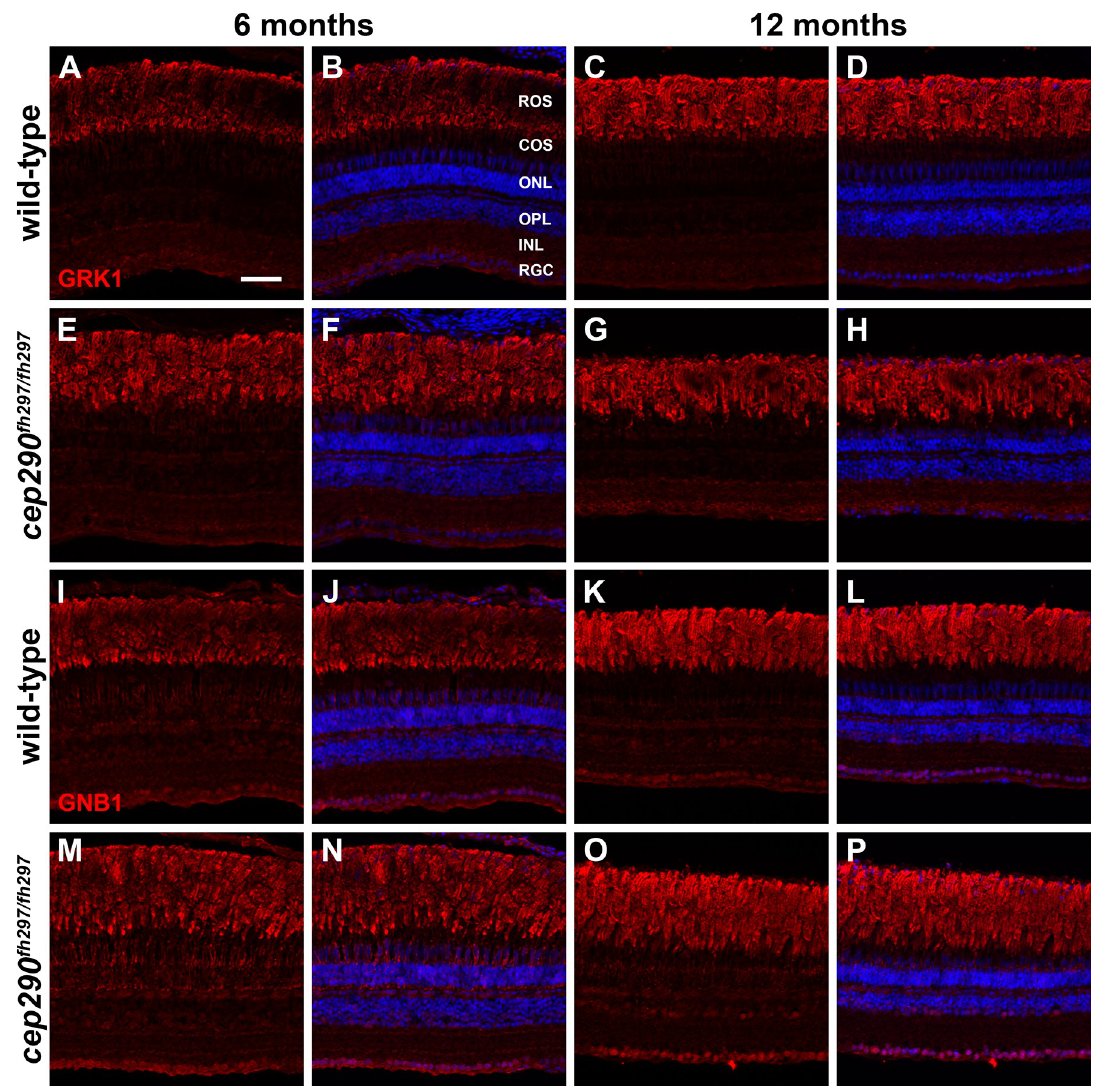
Fig 7. Immunolocalization of GRK1 and GNB1 in cep290 fh297/fh297 mutants at 6 and 12 months of age. Retinal cryosections of cep290 fh297/fh297 mutants and wild-type siblings were stained with polyclonal antibodies against rhodopsin kinase (A-H; GRK1) or with GNB1 polyclonal antibodies against the β subunit of rod transducin (I-P) to label rod outer segments at both 6 and 12 months of age. ROS, rod outer segments; COS, cone outer segments; ONL, outer nuclear layer; OPL, outer plexiform layer; INL, inner nuclear layer; RGC, retinal ganglion cells. Scale bar: 50 μ m. animals with homozygous mutations in two distinct genes may reflect the additive effect of two independent phenotypes and not necessarily a role for second-site modifiers. Because the loss of cep290 leads to slow cone degeneration in zebrafish, we asked whether heterozygous mutations in genes encoding other cilia proteins would accelerate degeneration. The Cc2d2a and Ahi1 proteins are components of the MKS module that make up part of the TZ [28]. In humans, mutations in AHI1 and CC2D2A cause Joubert Syndrome and both genes have been proposed as potential modifiers of CEP290 [12, 33]. Cep290 directly binds Cc2d2a through an N-terminal domain of Cep290 [12] and Cep290 is predicted to bind Ahi1, suggesting that these connections are critical for TZ assembly or stability. Mutations in ARL13B also result in